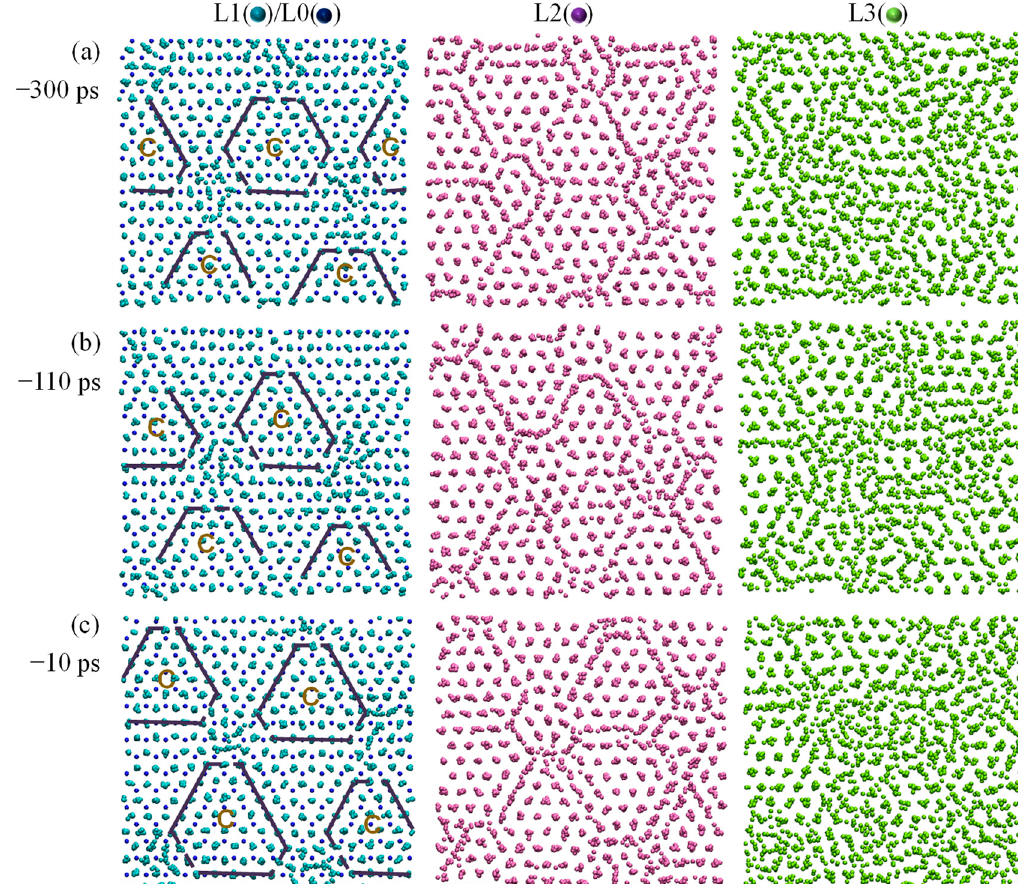
Figure 2. Evolution of the 2D ordered structure at the liquid/substrate interface in the system with f = − 8% at T n = 760 K. Time-averaged atomic positions of L1(on top of L0), L2 and L3 at ( a ) t = − 300 ps; ( b ) t = − 110 ps; and ( c ) t = − 10 ps showing the dynamic nature of the 2D ordered structure. “C” marks the stacking fault that is surrounded by partial edge dislocations (the solid lines).